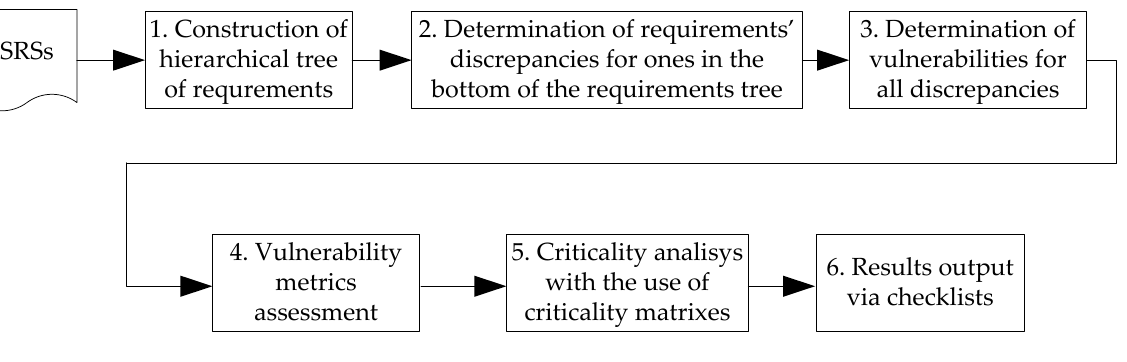
Figure 6. Overall sequence of IMECA application.